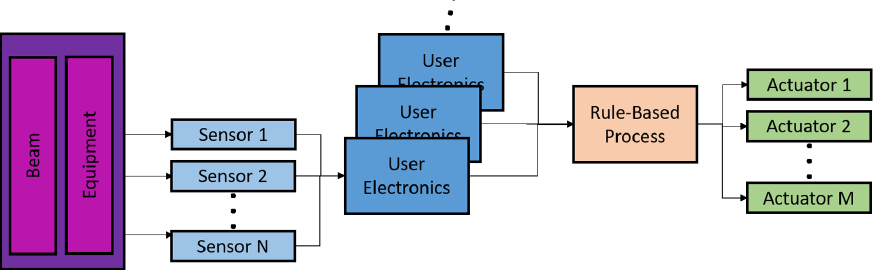
FIG. 1. Functional block diagram of a generic interlock system. The scheme shows a possible connection of the sensors able to detect faults to the interlock actuators.